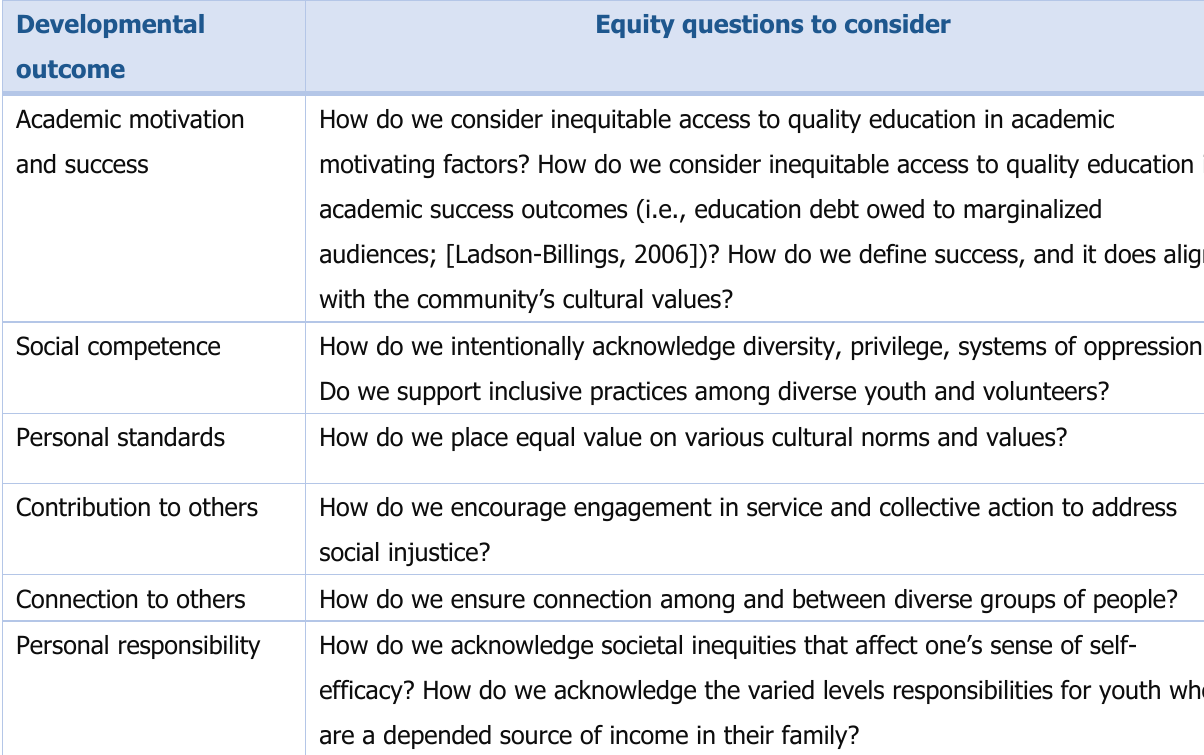
Table 4. Equity Considerations for 4-H Thriving Developmental